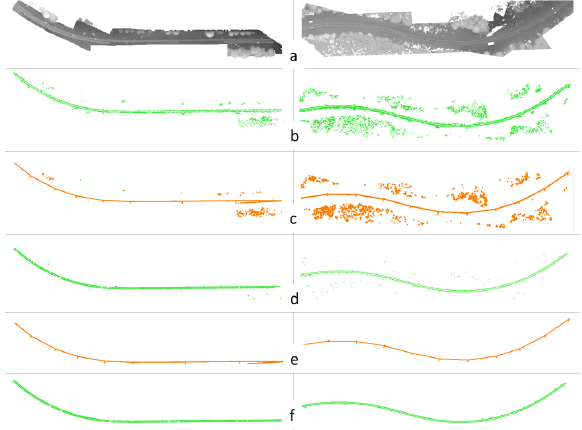
Figure 6. Detection of rail points per step. Input point cloud (a), rough detection of rail points (b) and contact wires (c), inliers of RANSAC fitting (d), large segments of inliers on wires (e), final rail points (f) after checking parallelism and checking nearby wire